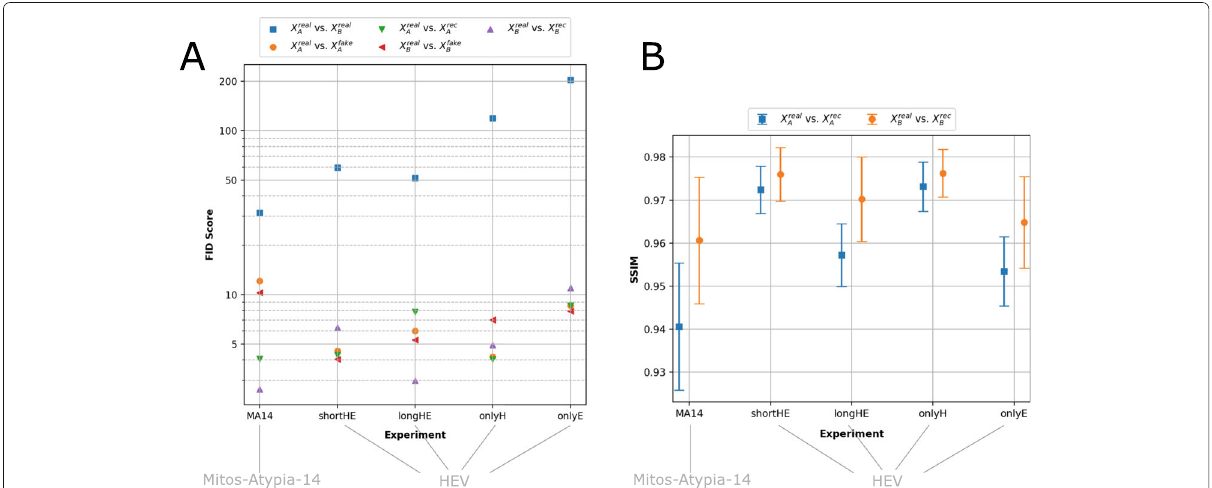
Fig. 5 Evaluation of our experiments using FID and SSIM scores. A ) FID scores between real and generated (fake, rec) images. For identical images the FID is zero, whereas it increases with noise and disturbances. B ) SSIM scores between real vs. rec images. The SSIM scale ranges from 0 to 1 and is close to zero for hardly similar images. A table with all FID and SSIM scores is presented in the Appendix